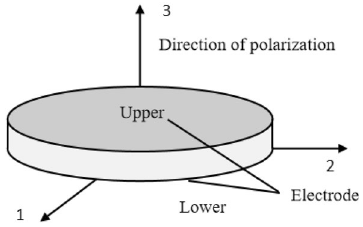
Figure 5. The polarization direction of the PZT patch.